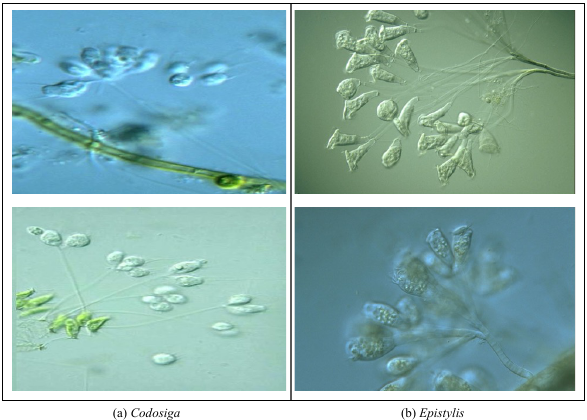
Figure 15. The example images of Codosiga and Epistylis in EMDS-6.